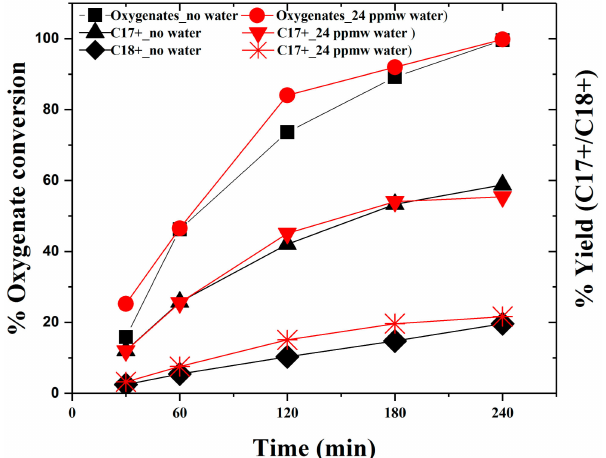
Figure 6. Effect of an equivalent amount of water in choline hydroxide on the HDO of oleic acid at 54 bar, 320 ◦ C, and 1000 rpm of stirring.